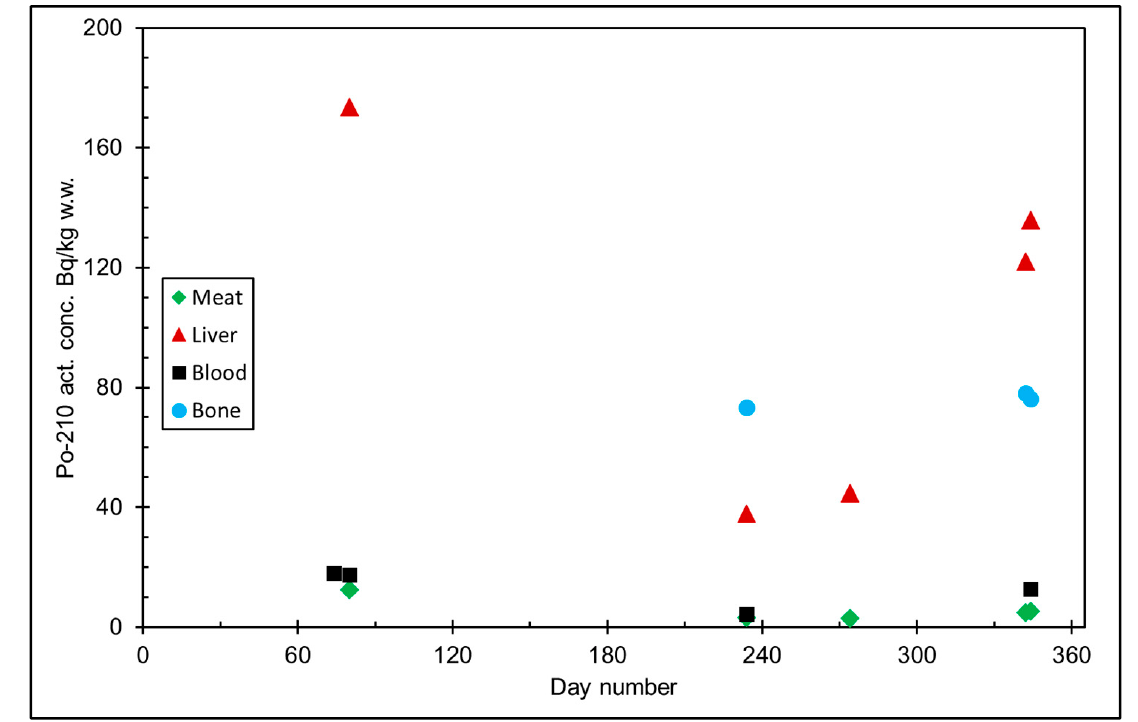
210 Pb and 210 Po activity concentrations (Bq/kg wet weight) in reindeer tissues, compiled from data in Figure 4. Average [15]. The black vertical lines indicate the range of individual values.